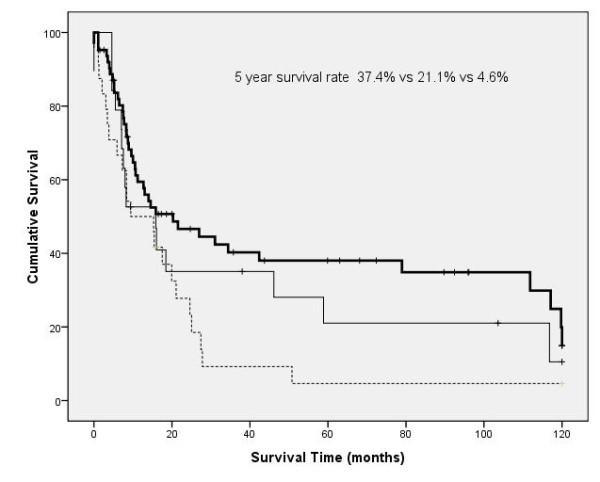
Survival curve according to node involvement (thick solid line: N0, solid line: N1, dotted line: N2).